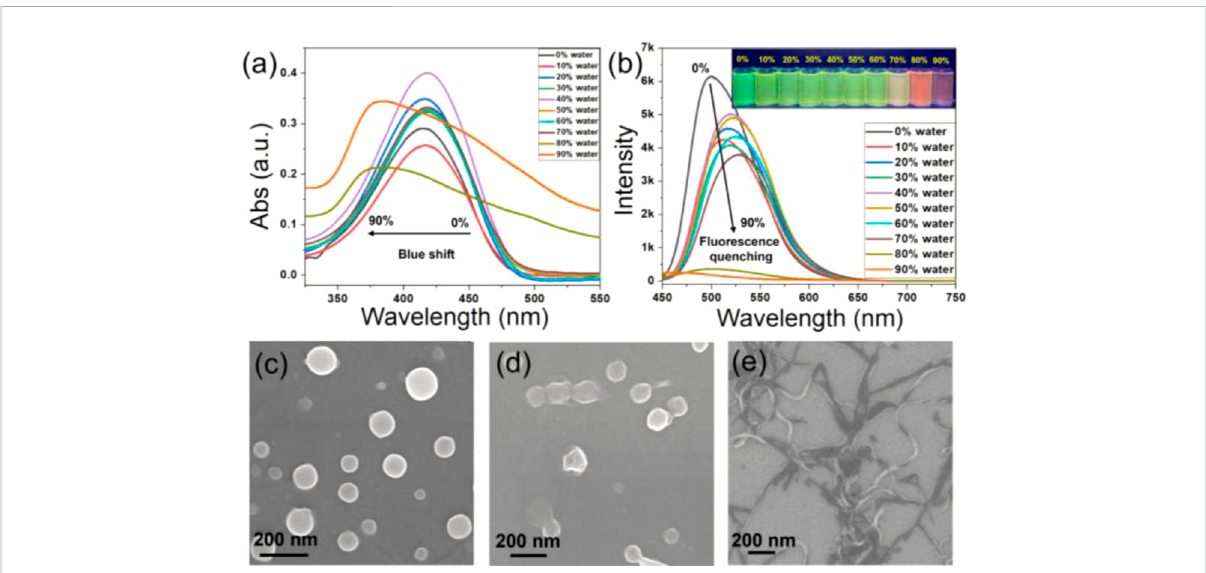
FIGURE 1 (A) absorption and (B) emission spectra of TPPA (0.4 mM, 4 ml) in 10 ml THF/water mixture with varying the water fraction from 0 to 90% with 10% of interval. (C) 0%, (D) 70%,and (E) 90%water content illustrating aggregation of spherical nanoparticles (0% W), semi-spherical oblong-shaped nanoparticles (70% W) to 1D-nano fi bers (90% W).